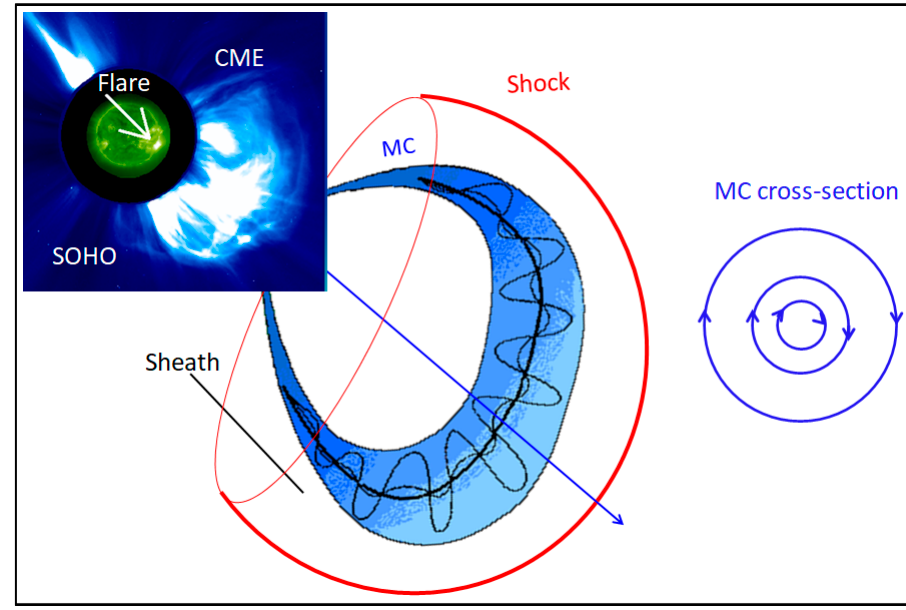
Figure 11. Illustration of the CME structure responsible for geomagnetic storms. The SOHO/LASCO image of a CME with the flare location shown in the superposed SOHO/EIT image ( top left ). The